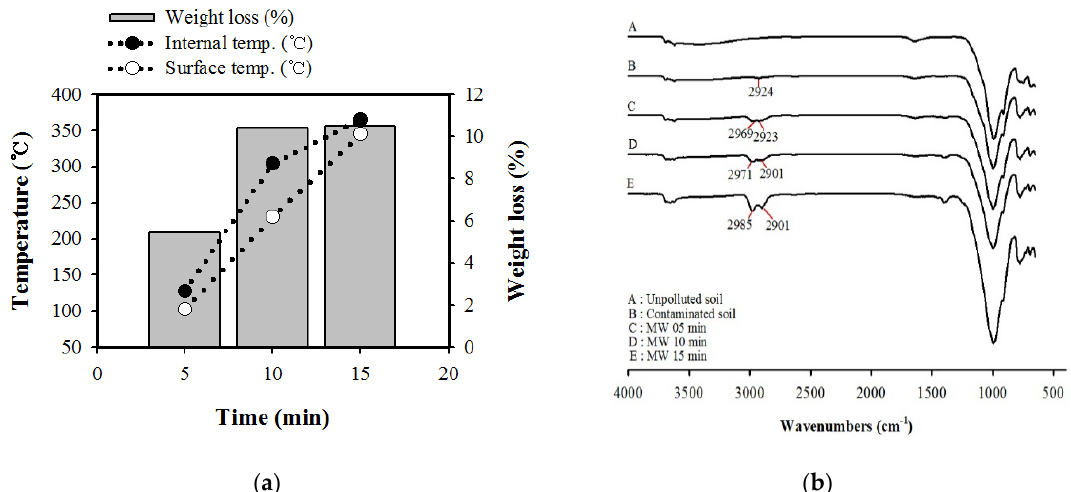
Figure 4. ( a ) Temperature, weight loss, and residual concentration from contaminated bulk soil with irradiation time. ( b ) FTIR spectra of soil sample before and after microwaves.